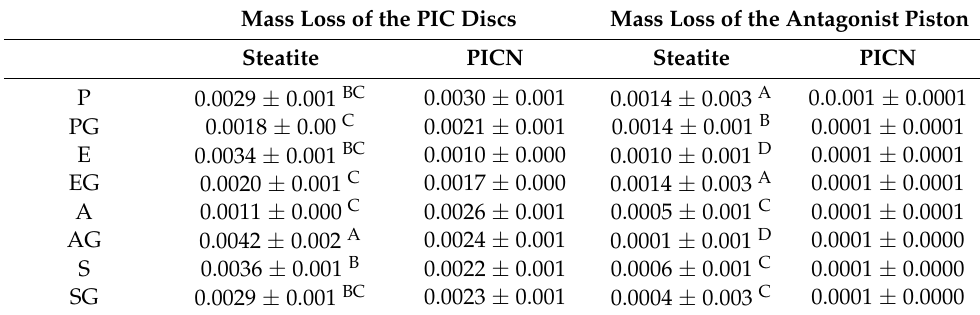
Table 3. Mass loss from the specimens (discs), the antagonists (pistons), and homogeneous groups according to the Mann–Whitney test.